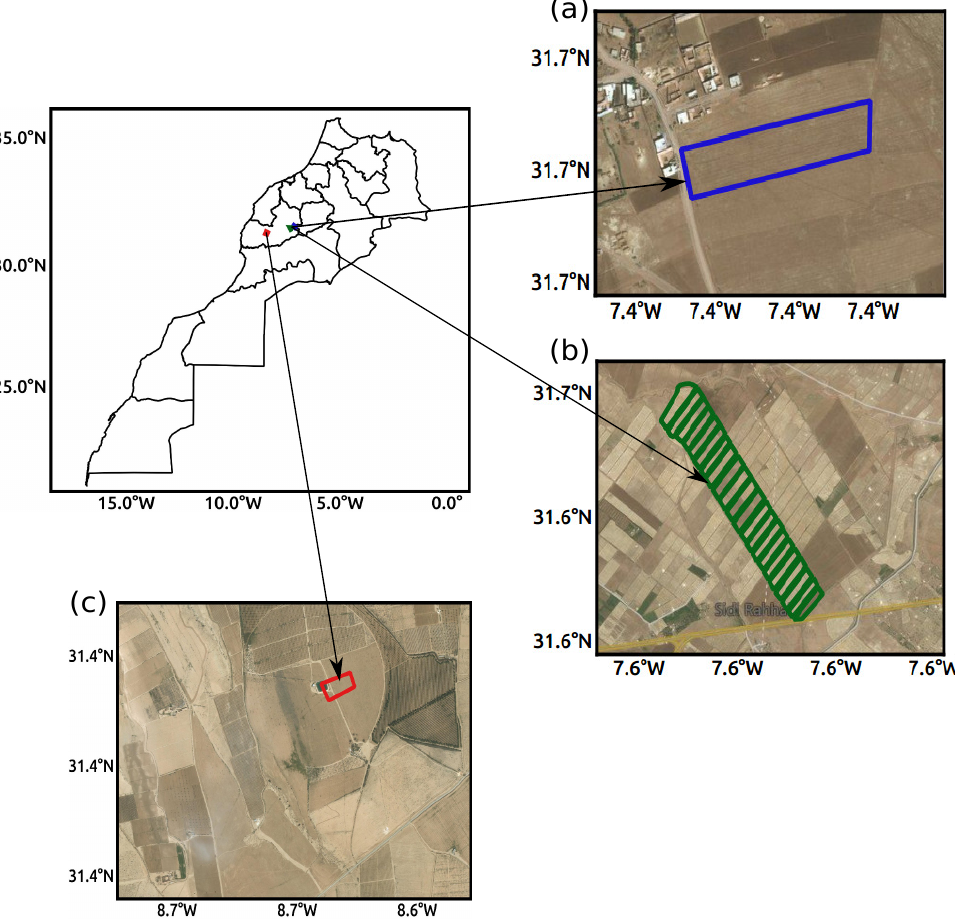
Figure 1. Location of the study area, including ( a ) Sidi Rahal, ( b ) R3 irrigated perimeter, ( c ) Chichaoua experimental